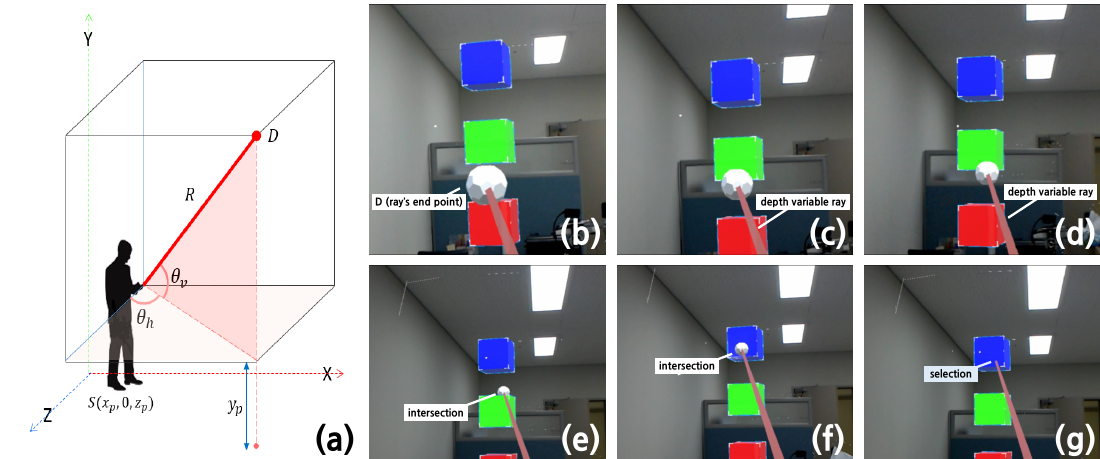
Figure 2. AR Pointer Implementation. ( a ) AR Pointer’s ray-casting using 6-Degrees of Freedom (DoF) Inertial Measurement Unit (IMU) sensor. ( b – g ) AR Pointer is capable of adjusting the depth of the ray and when the end point of the ray intersects the object, the user can select the object for